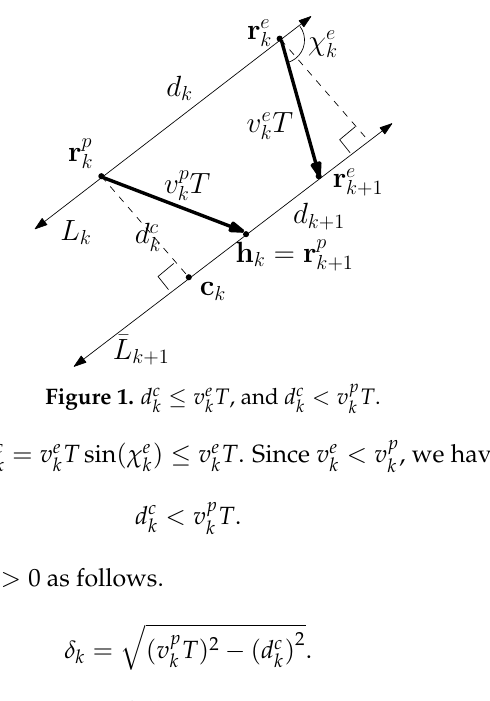
≤ v e T , and d c k k